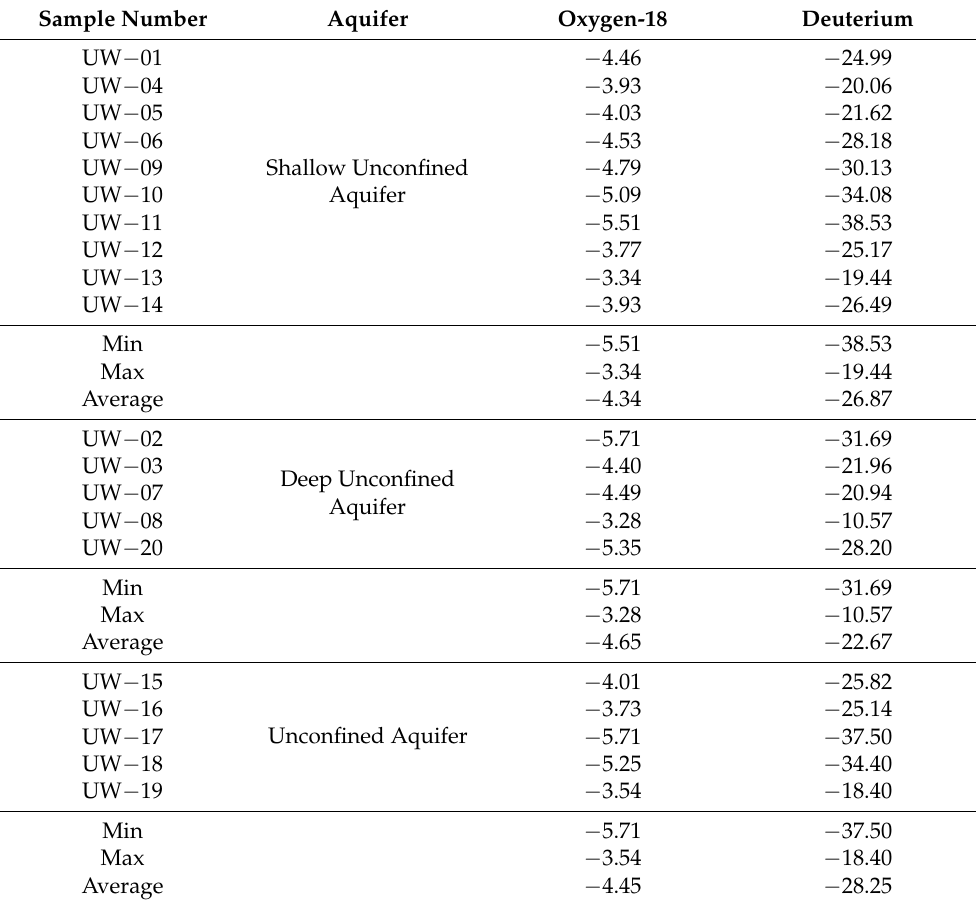
Table 2. Stable isotope data of 20 groundwater samples from Wajid